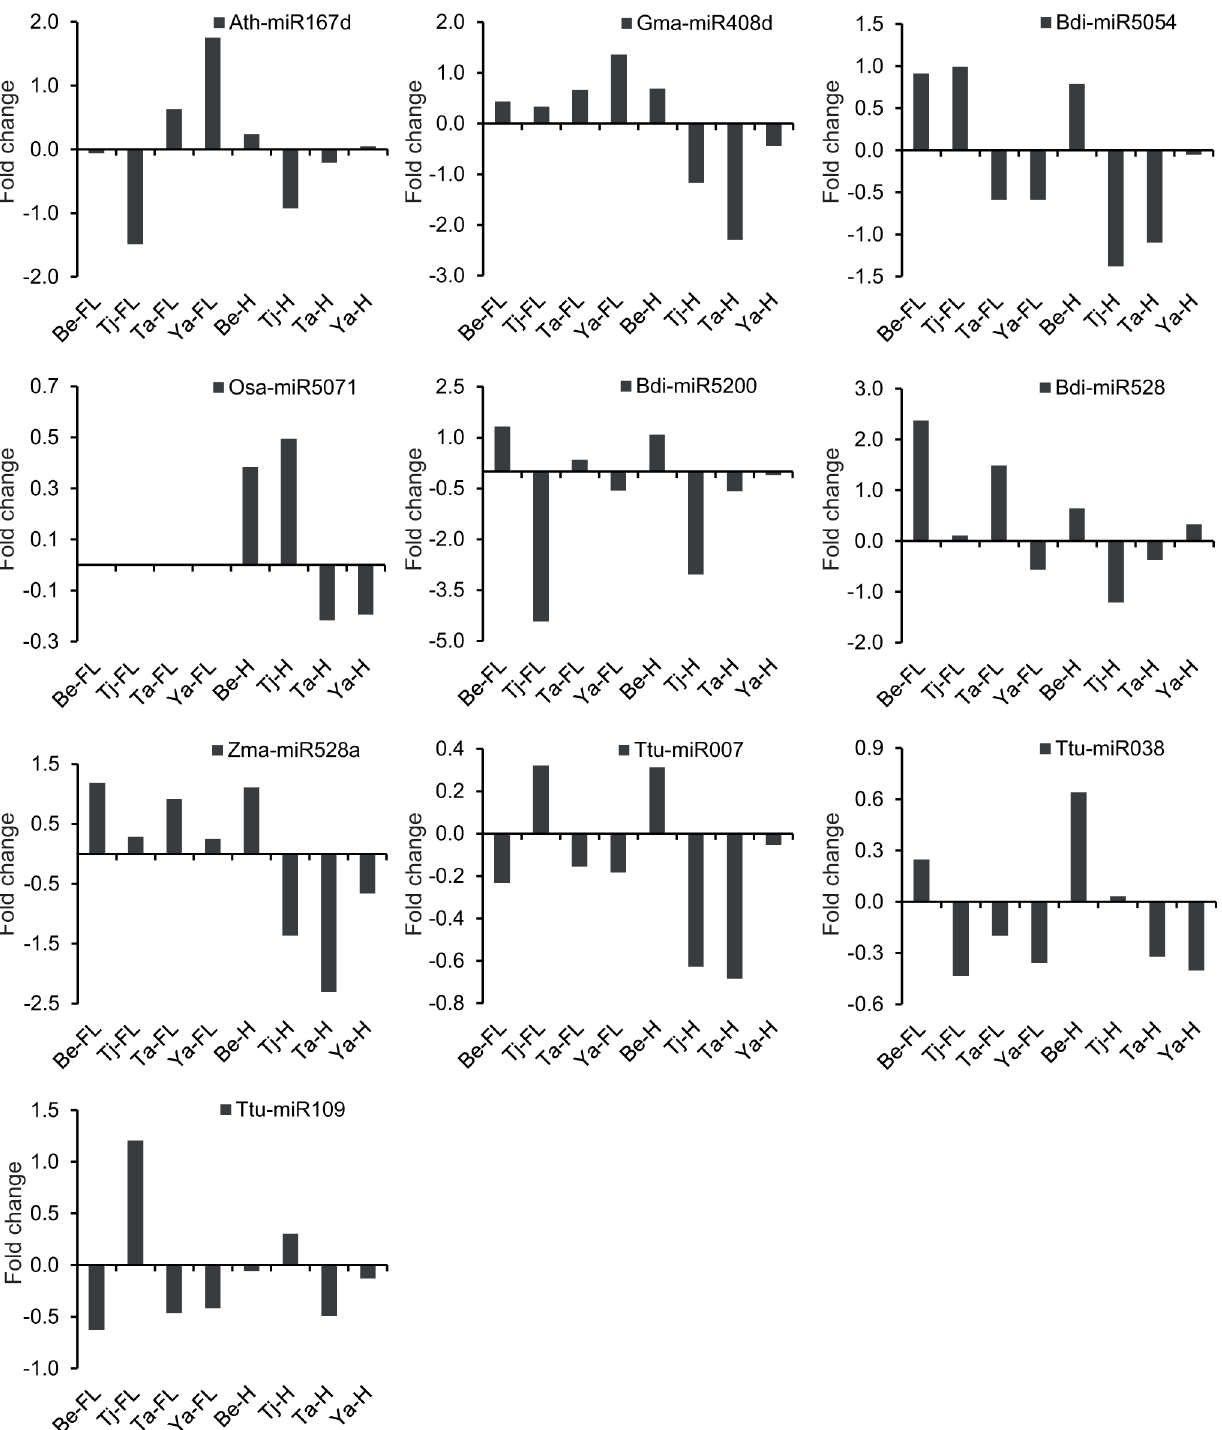
Fig 7. Expression analysis of stress responsive miRNA candidates by qPCR in four durum wheat genotypes. GAPDH was used as an endogenous control. The fold change is shown as a log2 value of miRNA expression in the water deficit libraries/miRNA expression in the control libraries. FL = Flag leaf samples; H = Head samples; Be = EGA Bellaroi; Ta = Tamaroi; Tj = Tjilkuri; Ya = Yawa; Ath = Arabidopsis thaliana ; Bdi = Brachypodium distachyon ; Gma = Glycine max ; Osa = Oryza sativa ; Ttu = Triticum turgidum ; Zma = Zea mays .